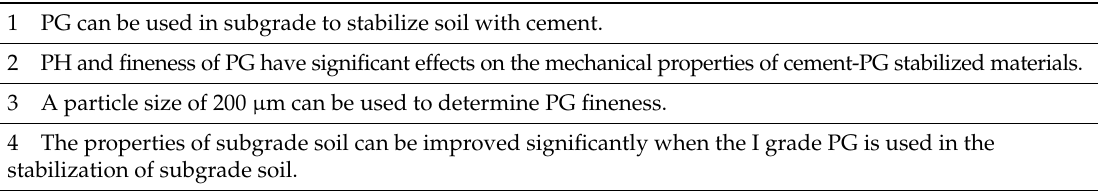
Table A1. Key information from the application